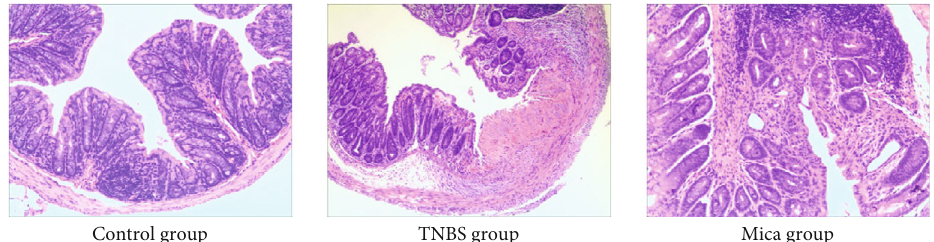
Figure 2: Histological analysis (HE staining) of the colon damage in di ff erent groups, × 200. Table 6: Macroscopic and histological damage score ð (cid:1) x ± s Þ .